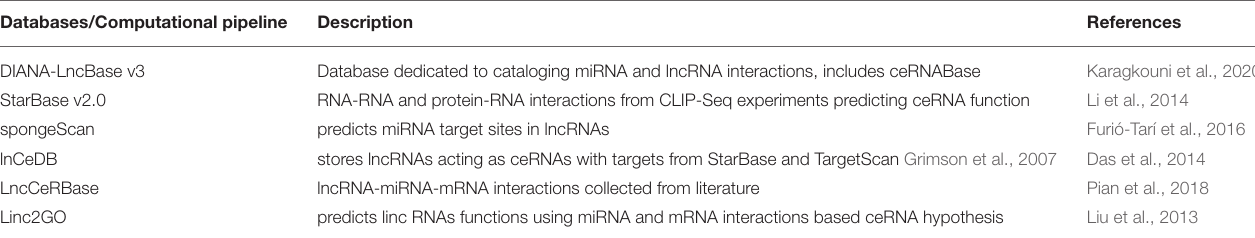
TABLE 1 | Databases and computational pipelines predicting lncRNAs functioning as ceRNAs.